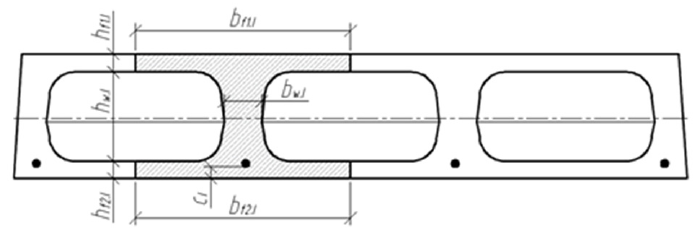
Figure 9. Slab cross-section I-I, where the perimeter of the void is greatest. The cross-section of the longitudinal fragment along the span is variable. Existing deflection calculation methods estimate the moment of inertia of the cross-section when the cross-section of the beam or slab along the span is not variable. Figure 10 shows a scheme for determining the position of section II-II, in which the transformed moment of inertia of the cross-section must be determined. A triangle is formed at the void, perpendicular at · 0.5 · l 0.5 · l b , and the distance between section II-II and section I-I is 2 b , or from the edge of 3 · 0.5 · l = l the void 1 b b /6. 3